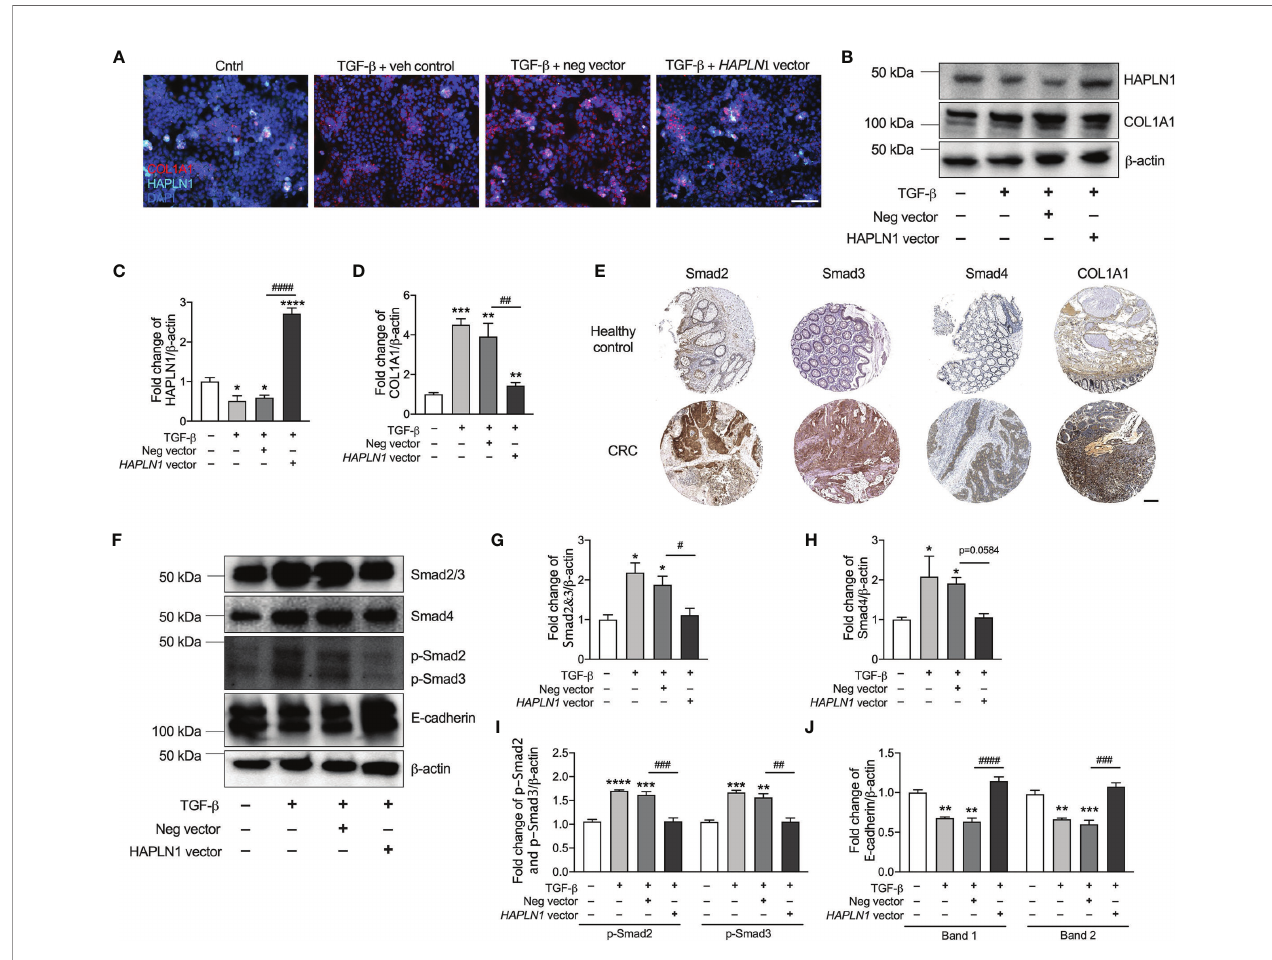
FIGURE 6 | HAPLN1 regulates collagen via the TGF- b signaling pathway and E-cadherin to control tumor growth in colorectal cancer (CRC). Human CRC epithelial (Caco-2) cells were transfected with HAPLN1 overexpression or negative control plasmid, and vehicle controls received media. Cells were then challenged with human recombinant TGF- b protein. (A) Cells were stained with HAPLN1 and COL1A1 fl uorescent antibody after 24 h of TGF- b and assessed by immuno fl uorescence (scale bar = 100 m m). (B) HAPLN1 and COL1A1 proteins were assessed in cell lysates by immunoblot. Fold change of densitometry of HAPLN1 (C) and COL1A1 (D) was normalized to b -actin. (E) Smad2, Smad3, Smad4, and COL1A1 proteins in human colon healthy controls and tumors from CRC patients by immunohistochemistry in the Pathology Atlas database (scale bar = 200 m m). (F) Smad2/3, Smad4, p-Smad2/3, and E-cadherin proteins were assessed in cell lysates by immunoblot. Fold change of densitometry of Smad2/3 (G) , Smad4 (H) , p-Smad2/3 (I) , and E-cadherin (J) was normalized to b -actin. n = 4. Results are mean ± SEM. * P < 0.05, ** P < 0.01, *** P < 0.001, **** P < 0.0001 compared with control cells receiving media. # P < 0.05, ## P < 0.01, ### P < 0.001, #### P < 0.0001 compared with cells transfected with negative control